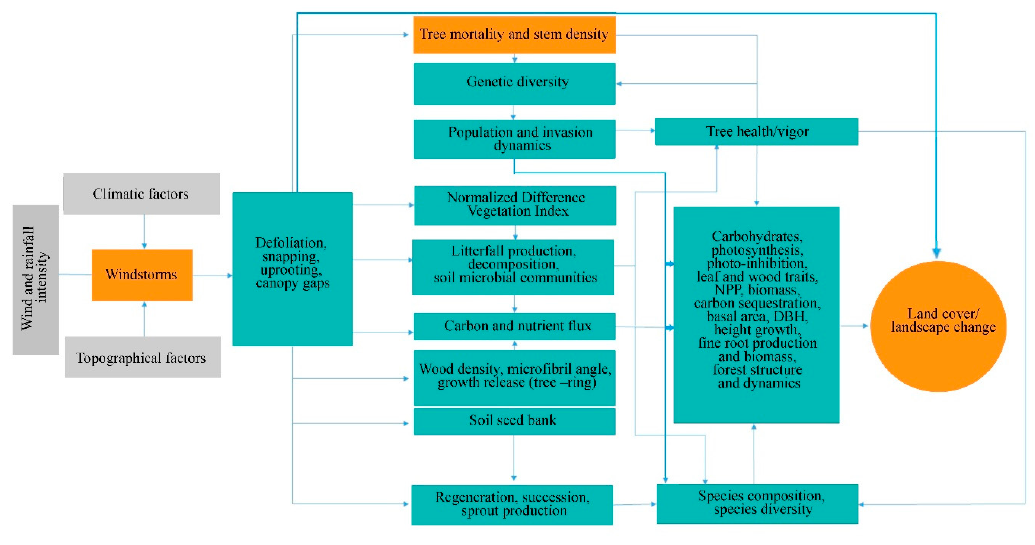
Figure 4. A conceptual diagram of the synergistic effects of windstorms on forest structure, composition, function, and dynamics.